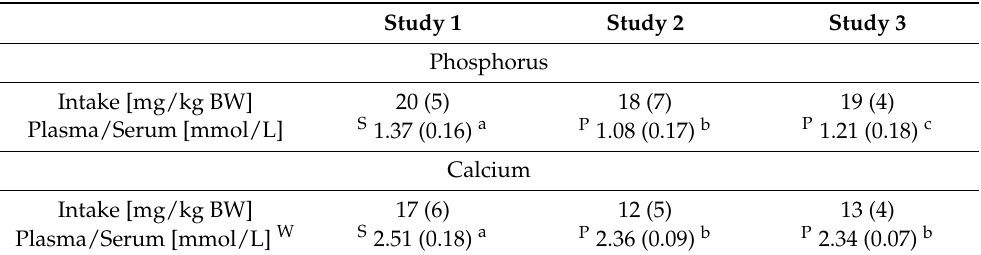
Table 3. Phosphorus and calcium intakes and serum/plasma concentrations of phosphate and calcium in three